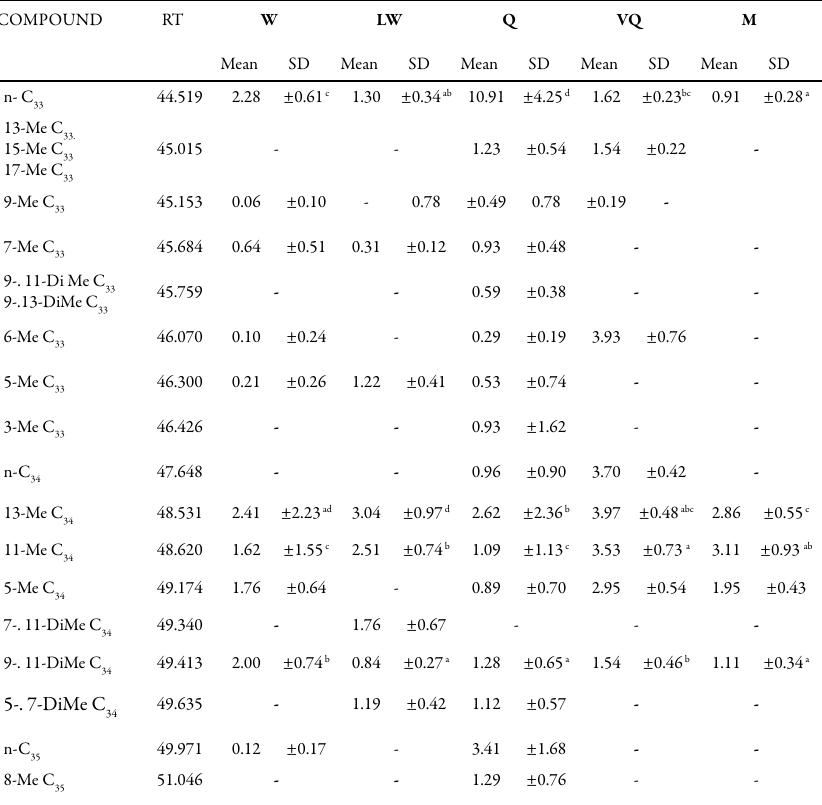
Table 1 (continued): Cuticular hydrocarbons present in the Camponotus textor workers (W), major workers (LW), queens (Q), virgin queens (VQ) and males (M). rT = retention time in minutes. dif- ferent letters indicate significant differences (p<0.001).